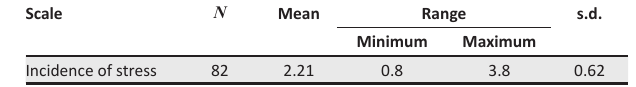
TABLE 2: Level of stress for perception of stress.